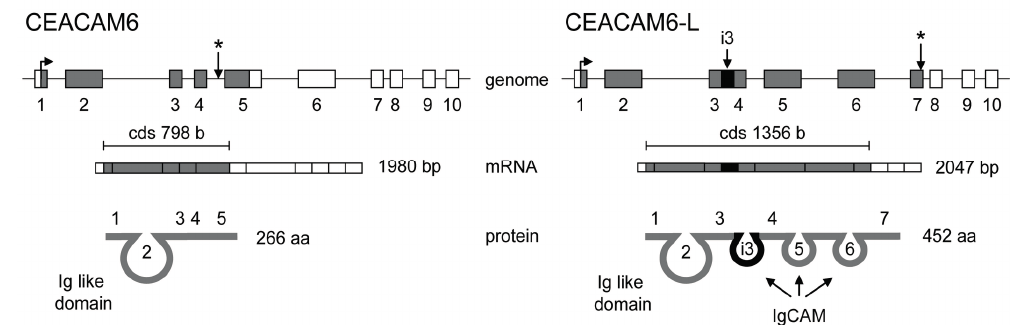
Figure 6. Carcino-embryonic antigen related cell adhesion molecule 6 (CAECAM6) and its novel spliced variant CAECAM6-Long (CAECAM6-L) from rat testis. Gene, mRNA and protein representation reproduced using data from [69]. Exons are numbered. Twisted arrow and star corresponded to ATG and stop codon, respectively. Intron 3 is denoted i3. Colored boxes corresponded to exons, thin line to introns except for i3, which was shown as a black box. White and grey boxes are for untranslated region (UTR) and coding sequences,